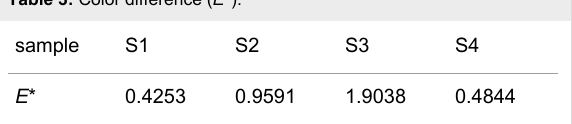
Table 3: Color difference ( E *).